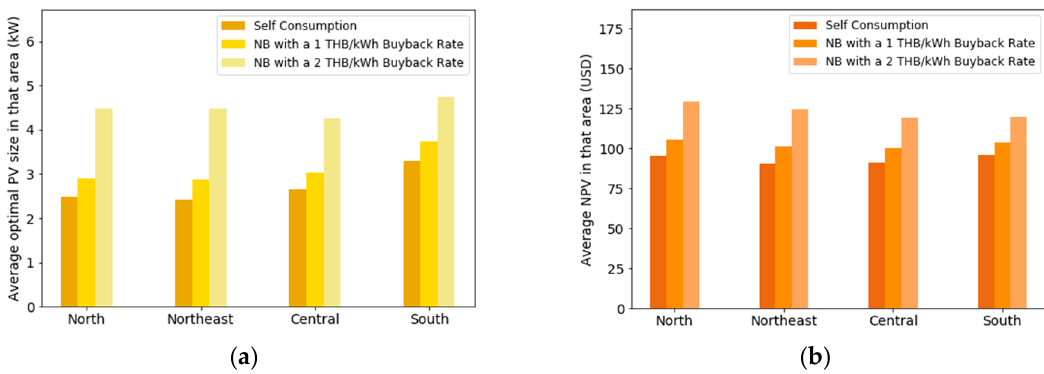
Figure 9. Comparison of ( a ) average optimal PV size and ( b ) NPV by region for SGS customers under a TOU rate. (Note: The average optimal PV size and the average NPV are the average values among all provinces within a region).